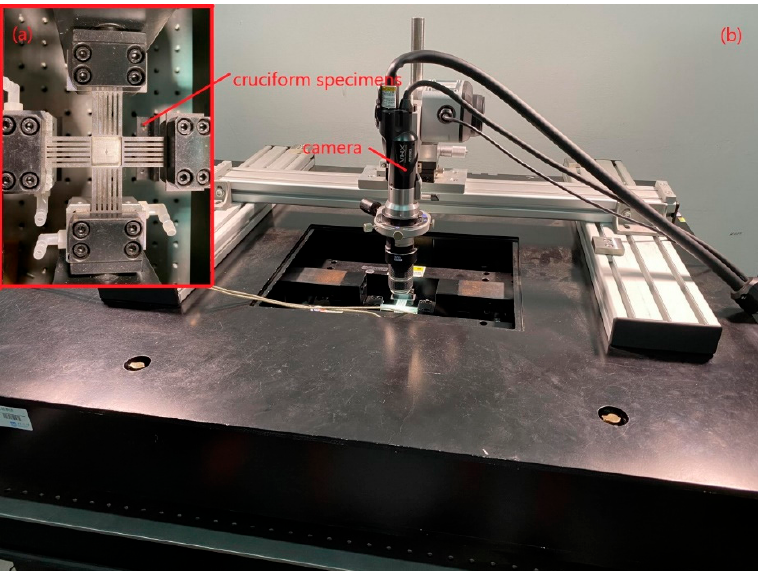
Figure 1. Biaxial test machine and cruciform specimen. ( a ) Specimen clamping diagram ( b ) Test Machines.